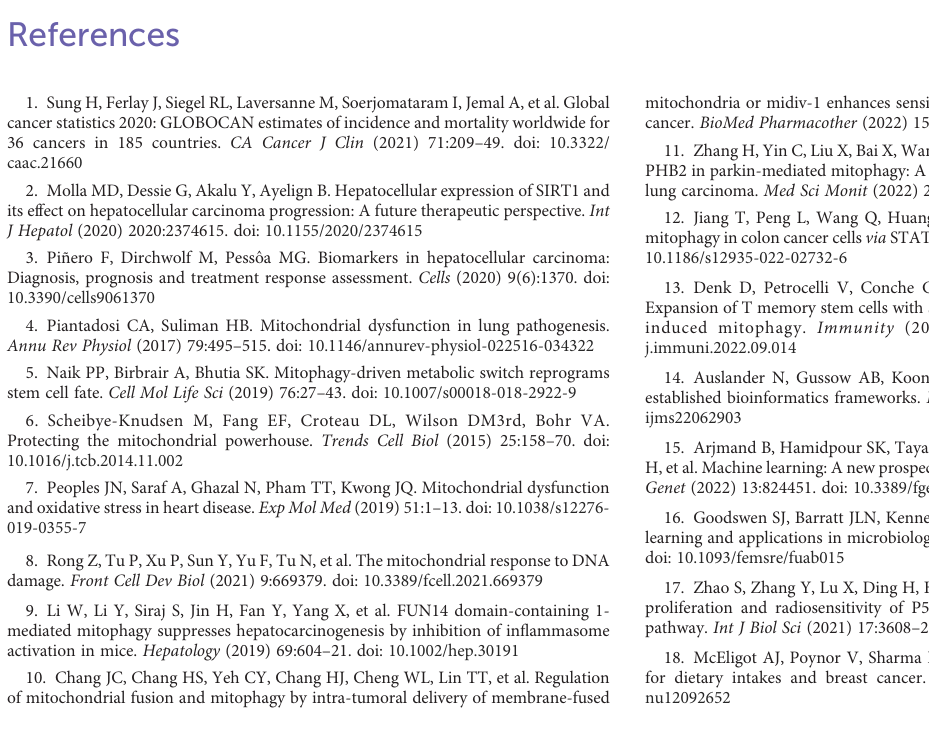
SUPPLEMENTARY FIGURE 1 Flow chart of our study. SUPPLEMENTARY FIGURE 2 The heatmap of DEGs between cluster A and cluster B patterns. SUPPLEMENTARY FIGURE 3 Quality control of single-cell sequencing data. (A) Gene expression levels in each cell of the 2 samples were in the range of 250-5000, and the percentage of mitochondrial, ribosome, and hemoglobin genes was controlled below 15%. (B) We chose 2000 hypervariable genes from all of the genes, which are in red, and tagged the fi rst ten. (C) Reduced- dimensional representations of the cells are visualized in the scatter plot. (D) After dimension reduction through PCA, we found that the cells were clustered into 20 clusters. SUPPLEMENTARY FIGURE 4 Enrichmentanalysisofdifferentially expressedgenesinthehigh-andlow-risk group in the TCGA cohort. (A, B) In GO and KEGG analyses we found that these genes were mainly associated with drug metabolism